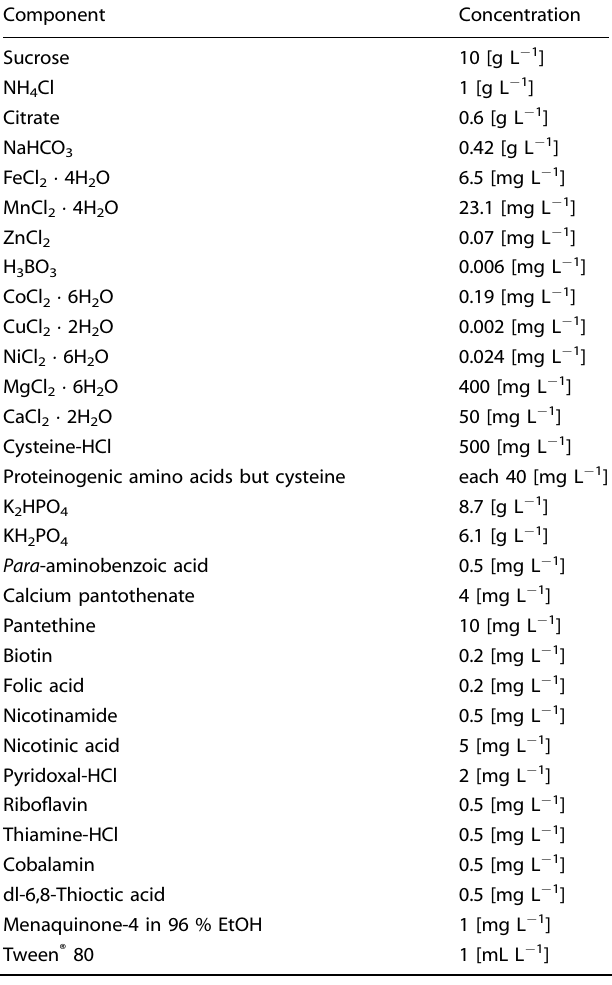
Table 1. Composition of the newly formulated chemically de fi ned medium for growth of BB-12 and